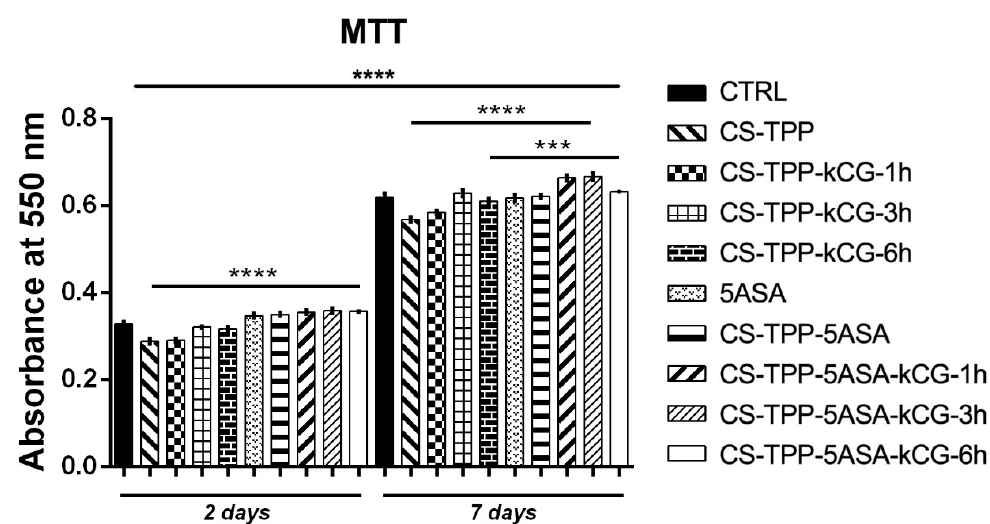
Figure 12. Cell viability and proliferation profile registered after MTT assay for CS-TPP beads at 2 and 7 days of culture. Statistical significance: *** p < 0.001, **** p < 0.0001.